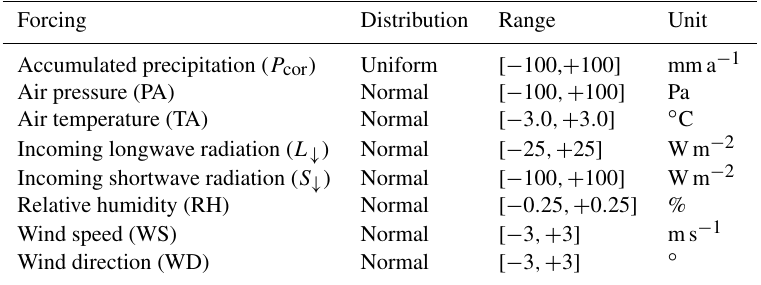
Table 3. Forcing data for the snow models with the corresponding uncertainty σ used in the ensemble simulation. The ranges of PA, TA, S ↓ , L ↓ , RH, and WS are ranges as used by Raleigh et al. (2015). The WD range is according to the uncertainty given by the manufacturer and the P cor range is described in Sect.